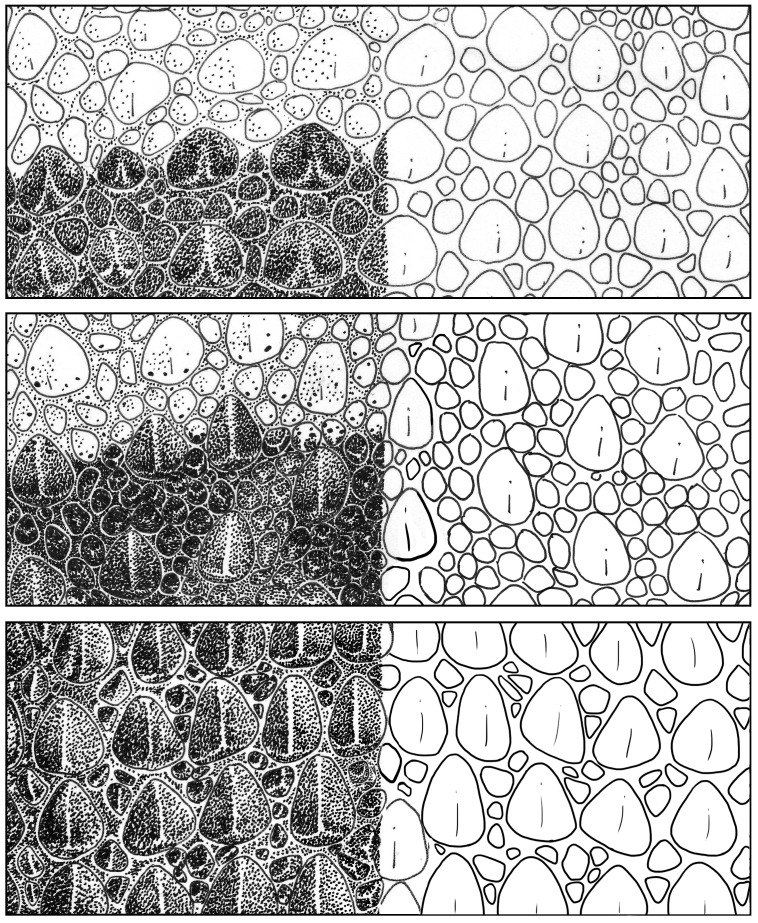
Arrangement of enlarged dorsal tubercles and small granule interspace scales in species of the Heteronotia spelea complex.(A) Pilbara H. spelea, (B) H. fasciolatus
sp. nov., (C) H. atra
sp. nov.